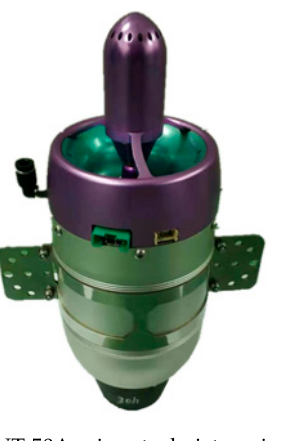
Figure 2. NT-50A micro-turbojet engine (MTE). Table 1. Some basic engine specifications of MTE.